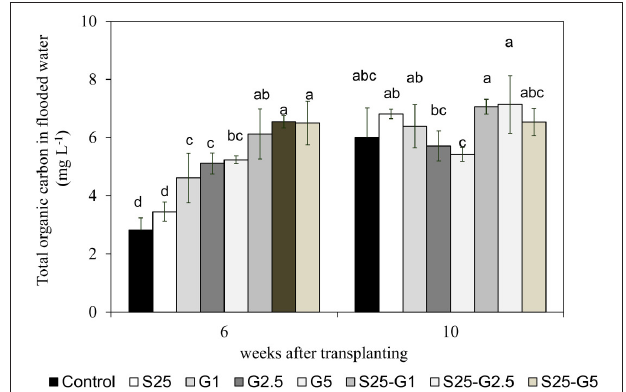
FIGURE 7 | Total organic carbon content in flooded water at panicle initiation stage and maturity stage of rice. Error bars: SD of three replications. The same alphabetical characters indicate values that do not differ significantly by using LSD at p < 0.05